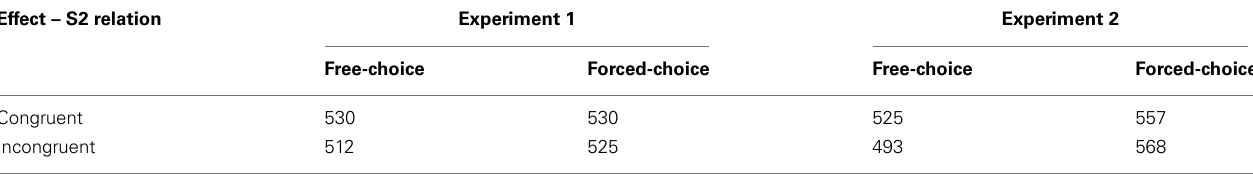
TableA1 | Mean RTs (ms) to Stimulus 2 from Experiments 1 and 2 as a function of Effect – Stimulus 2